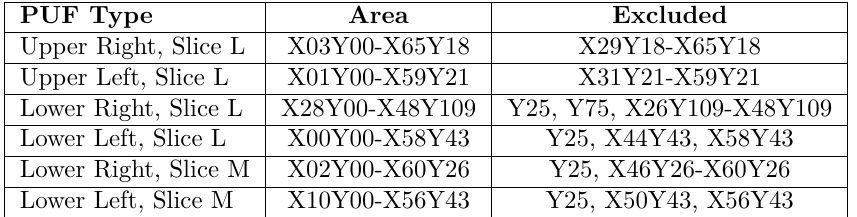
Table 2: Slice coordinates of used RO frequencies for each attacked PUF